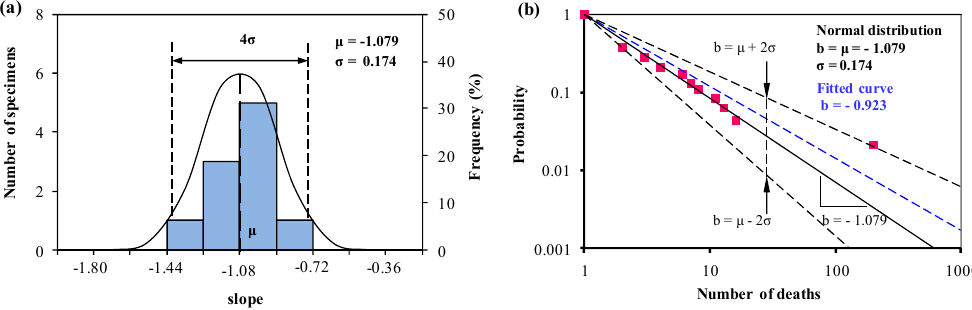
Figure 4. ( a ) Normal distribution analysis of the slope b i , and ( b ) predictions from Equation (1) and Equation (3) based on the normal distribution analysis of b i in ( a ) for Group 2 together with the statistical data (1931–2004) available in Oggero et al. [11].